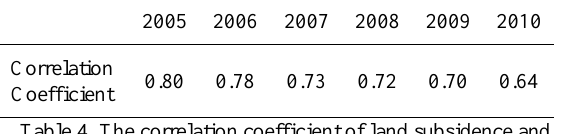
Table 4. The correlation coefficient of land subsidence and